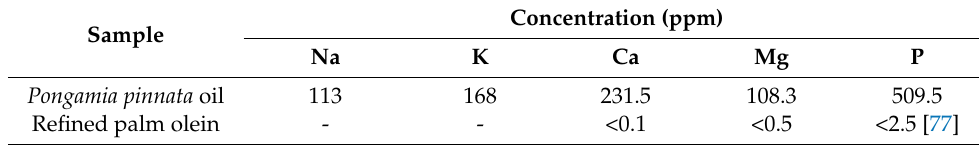
Table 6. The impurities in the